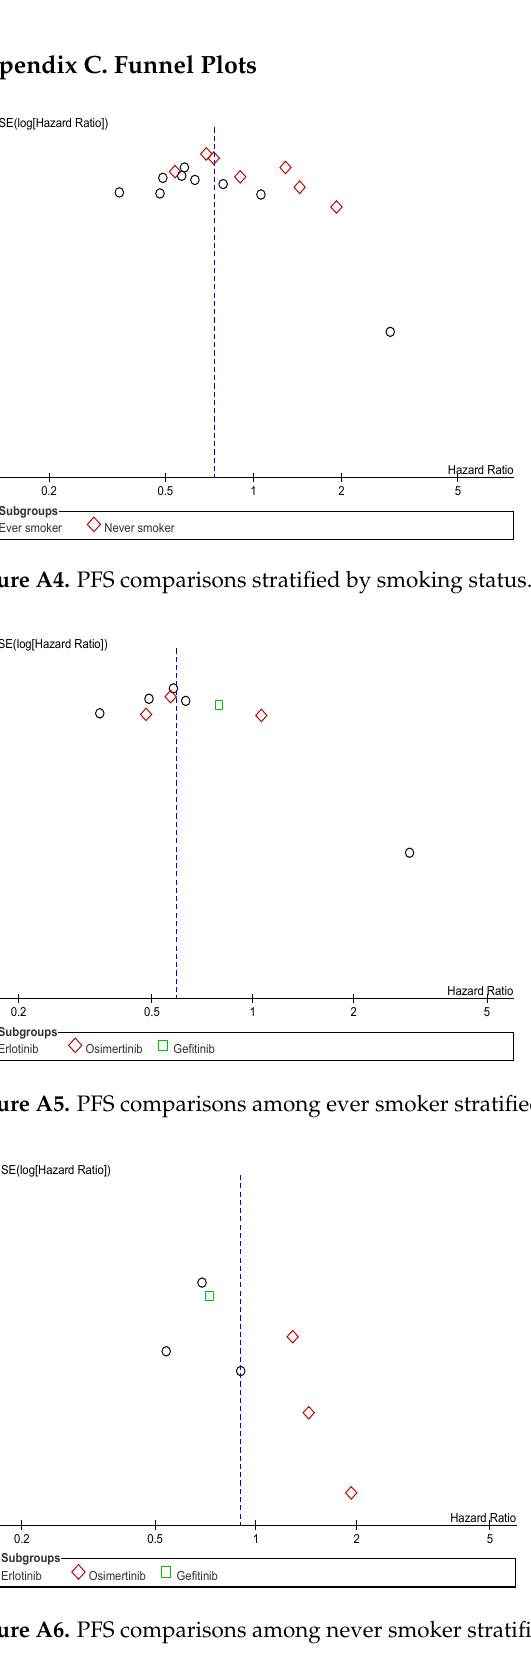
Figure A3. Forest plot and pooled response ratio for ORR.